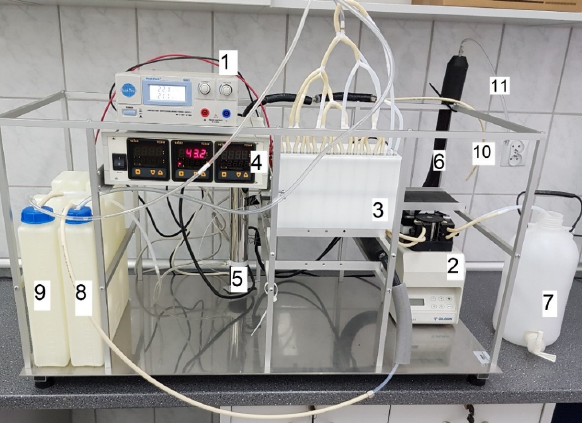
Figure 2. Measurement system of a laboratory 500 W alkaline water electrolyser unit (PP stack dimensions: 15 × 15 × 25.5 cm, with nine cells connected in series), where: 1 is a dc. 30 V/30 A power supply from PeakTech, 2 is Gilson Minipuls 3 peristaltic electrolyte recirculation pump, 3 is electrolyser stack, 4 is electrolyte heater with electronic controller, 5 is silica gel beads-based hy- drogen desiccant column, 6 is silica gel beads-based oxygen desiccant column, 7 is periodically replenished electrolyte recirculation tank, 8 is anolyte reservoir, 9 is catholyte reservoir, 10 is dry hydrogen outlet and 11 is dry oxygen outlet.